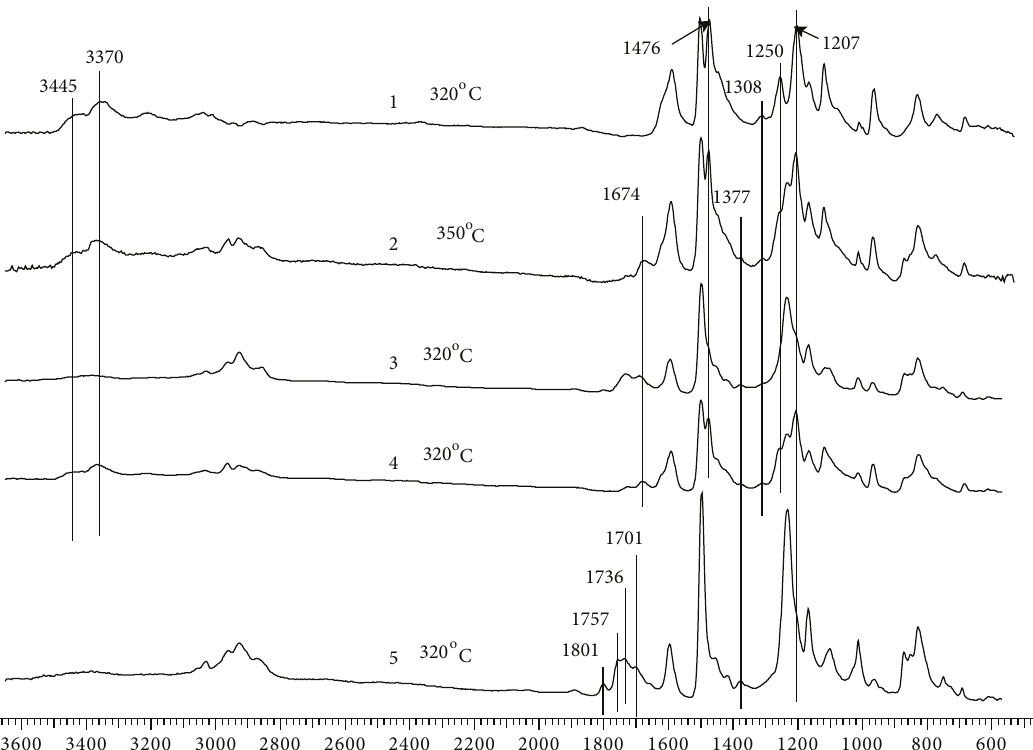
Figure 4: FTIR spectra of heat-treated 1,3-BAPB (XV) (1) and the following cured blends: ROL-II-1,3-BAPB (XIV) (2), ROL-II-1,3-BAPB (VIII) (3), ROL-II-1,3-BAPB (XIII) (4), and neat ROL-II (IV) (5).